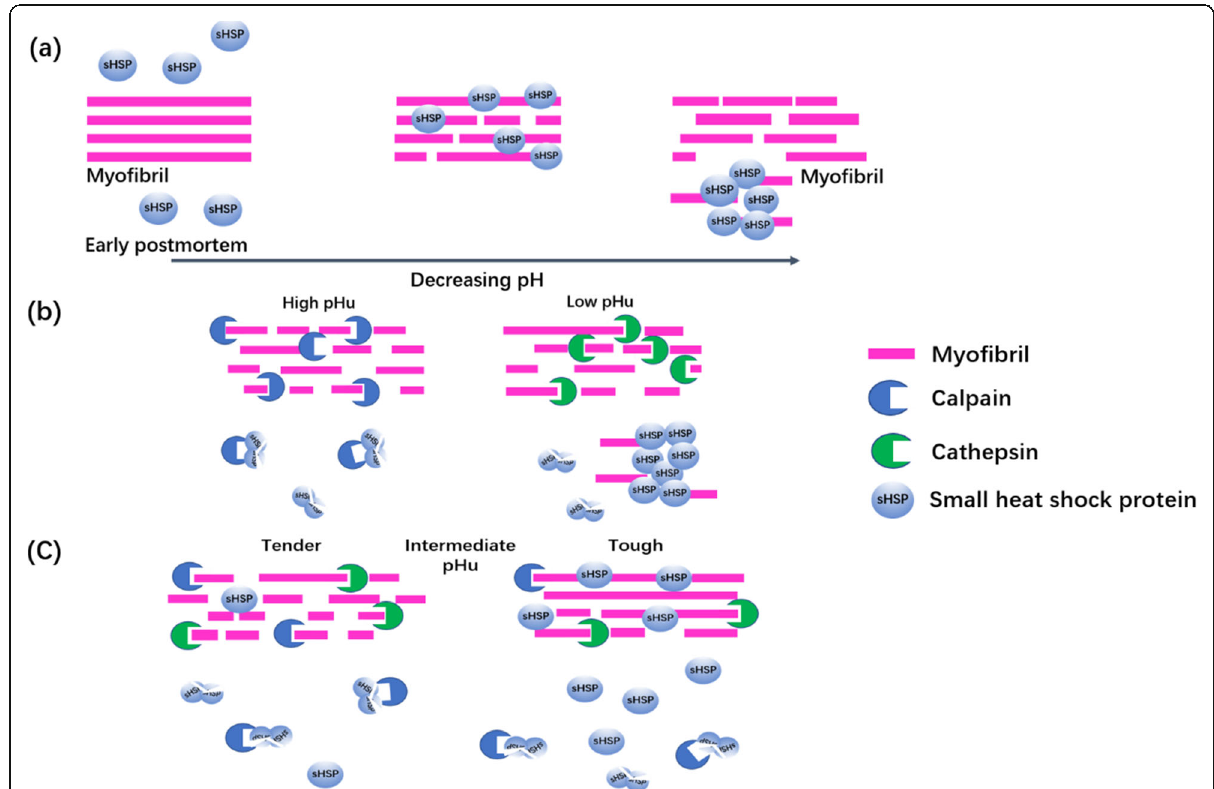
Fig. 2 Association of sHSPs with myofibrils in early intramuscular pH decrease ( a ), and sHSPs activity in myofibrils with high and low pHu ( b ), and intermediate pHu ( c ) (Lomiwes et al., 2014a, with